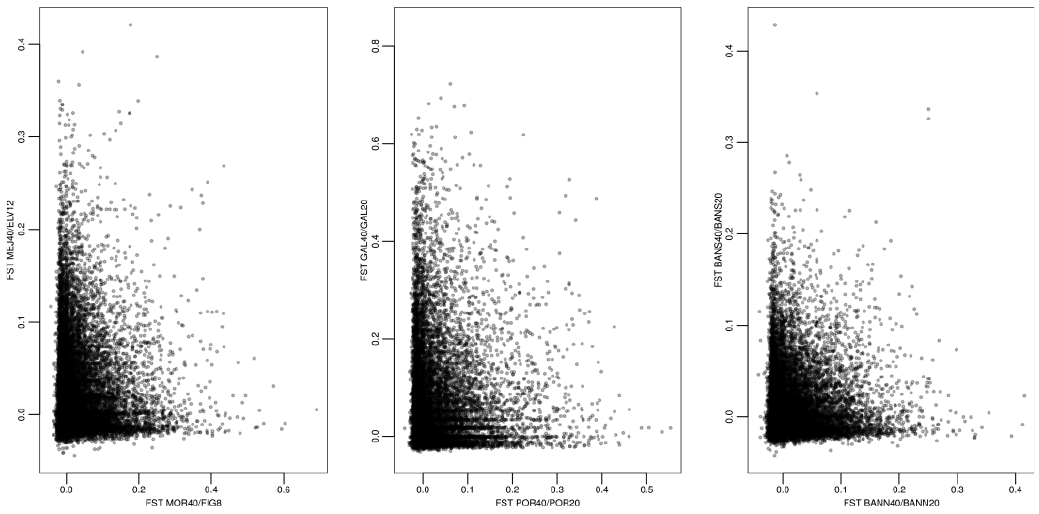
Figure S4. Joint distribution of between-depths F ST in the three geographical